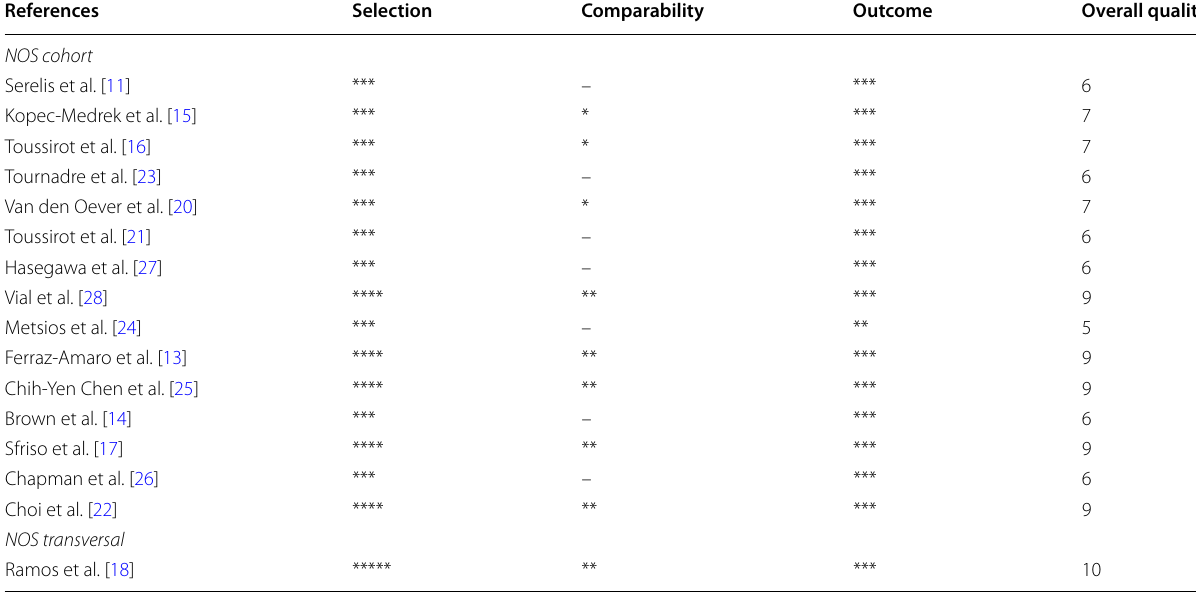
NOS, Newcastle–Ottawa